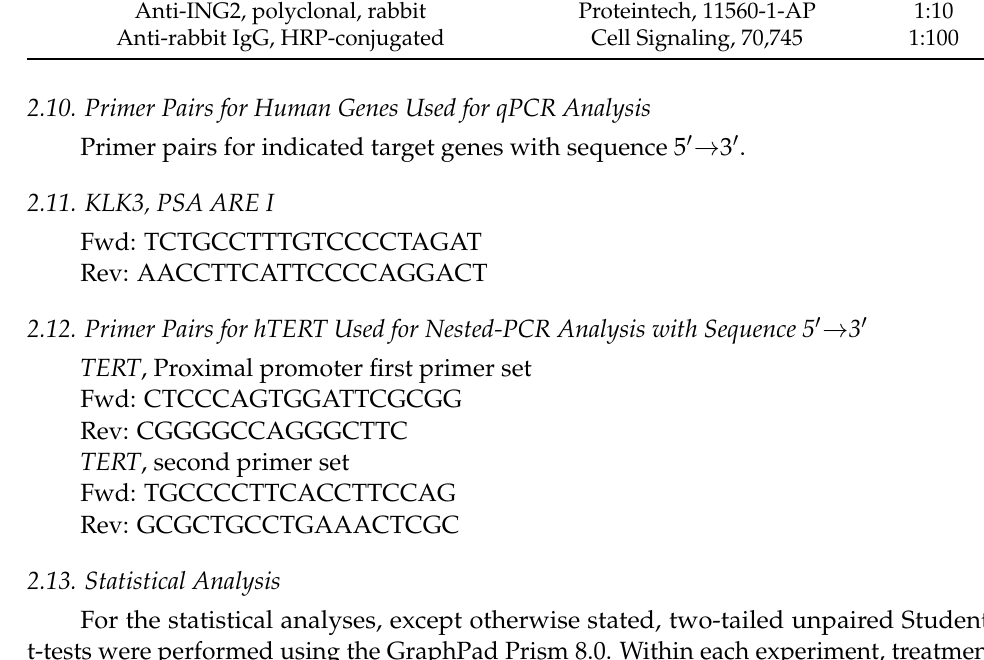
Table 1. Antibodies used for ChIP experiments. Primary Antibody Manufacturer/Catalog No. Dilution Anti-androgen receptor, polyclonal, and rabbit Merck, 06-680 1:15 Sigma Aldrich, 1:20 Anti-ING1, polyclonal, rabbit SAB1410716-100UG Anti-ING2, polyclonal, rabbit Proteintech, 11560-1-AP 1:10 Anti-rabbit IgG, HRP-conjugated Cell Signaling, 70,745